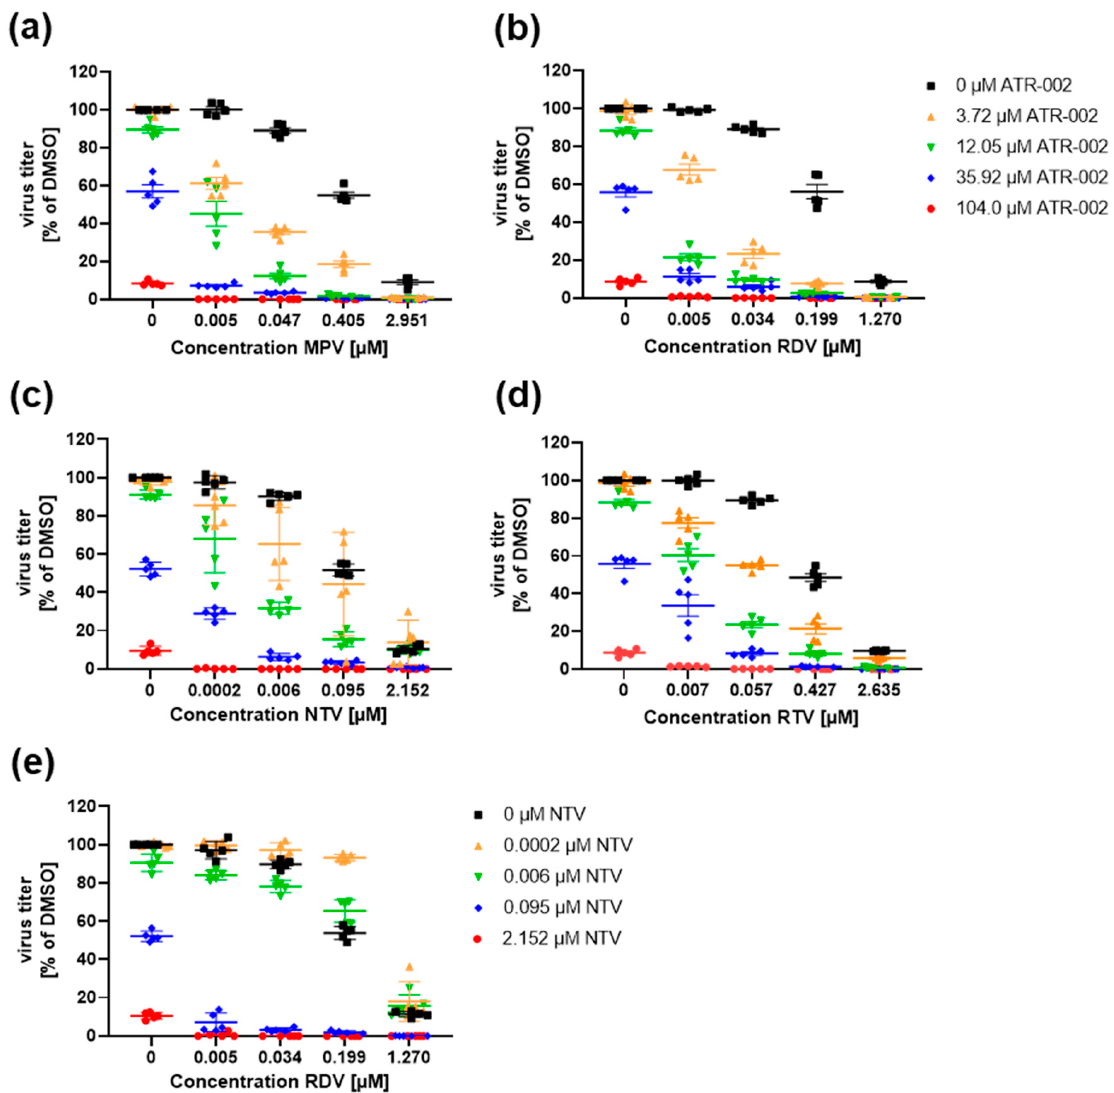
Figure 2. Antiviral effect of the combinational treatments in Calu-3 cells. Calu-3 cells were infected with SARS-CoV-2 (D614G) (MOI: 0.01). Combinational drug treatments were initiated 1 h.p.i. Viral titers were analyzed 48 h.p.i. Shown are means ± SEM of five independent experiments, each per- formed in triplicates. ( a – d ) DAAs (MPV, RDV, NTV, RTV) in combination with the HTA ATR-002.